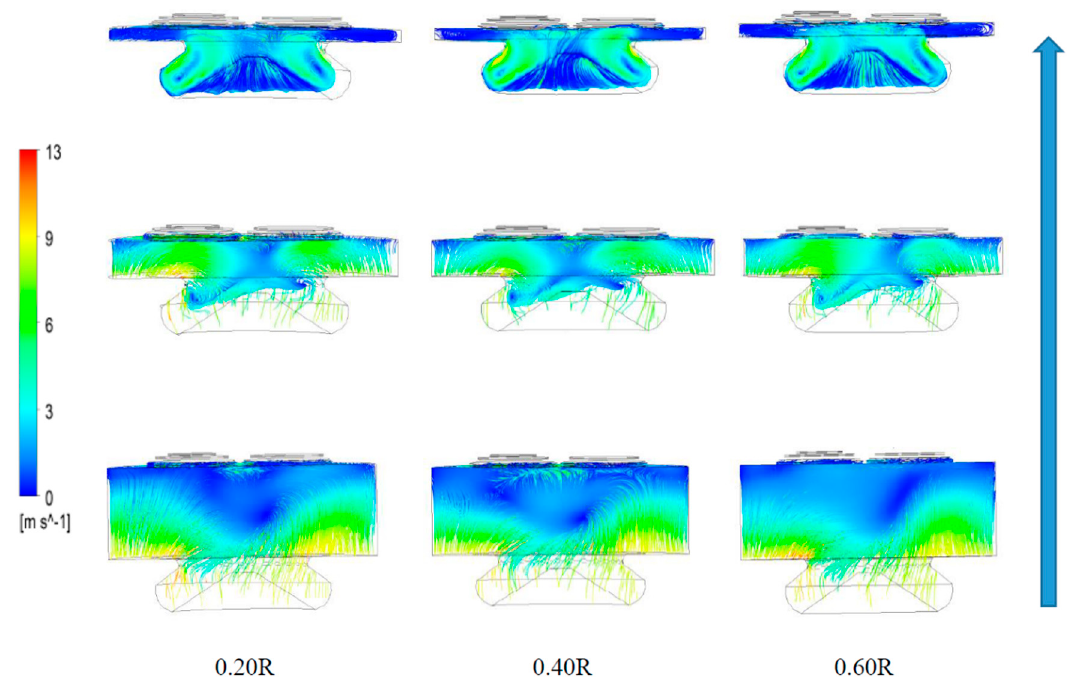
Figure 13. The computed streamline compression stroke at the 346° (top), 330° (middle) and 310° (bottom) crank angle.